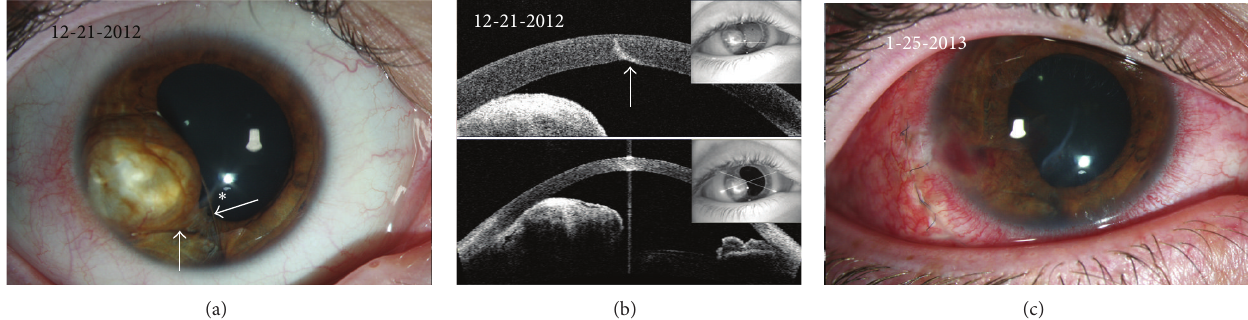
Figure 1: Clinical and diagnostic images from case 1: initial presentation. (a) Slit-lamp photograph of the patient’s right eye upon presentation two years after his initial penetrating ocular injury with a wire fence. An inferocentral corneal scar is seen (asterisk). The pupil is irregular with a large, opaque, iris cyst extending from 7 to 9 o’clock with two embedded cilia (arrows). The lens is clear with no signs of cataract formation. (b) Anterior segment optical coherence tomography (AS-OCT) images illustrating the healed corneal laceration (arrow) from the patient’s prior penetrating ocular injury and the location and contours of the iris implantation cyst. The cyst abuts the posterior cornea and there is absence of normal angle architecture. High reflectivity within the cyst indicates that the lesion is unlikely to be fluid-filled. (c) Slit-lamp photograph of the patient’s eye one week after debulking of the cyst and injection of 5-Fluorouracil (5-FU) within the cyst cavity. The cyst was approached through a temporal scleral tunnel incision to facilitate precise entry into the body of the cyst for drainage and prevent expulsion of debris into the anterior chamber. Following surgery, the cyst initially resolved and there is rounding of the